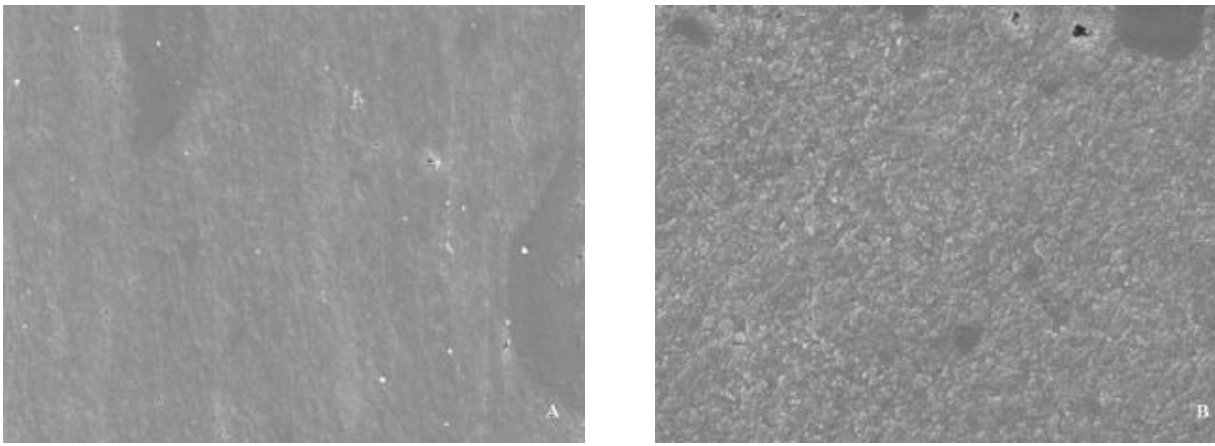
FIGURE 3 - Definite ORMOCER composite: (A) after polishing with Sof-Lex discs and before the mechanical toothbrushing test; (B) after the mechanical toothbrushing test. Original magnification